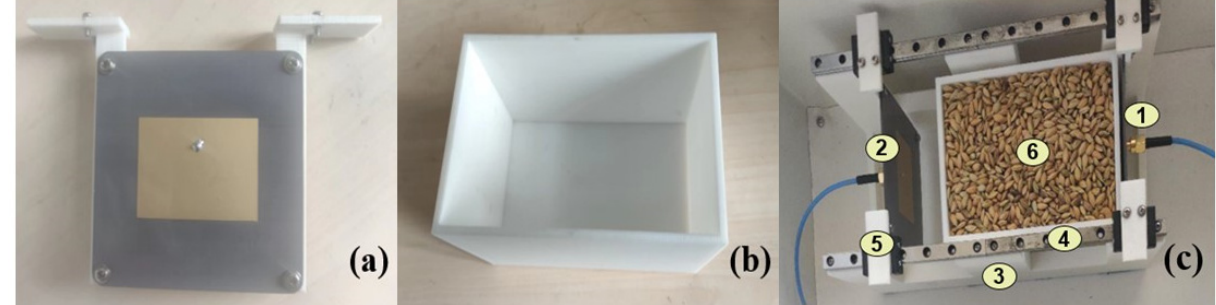
Figure 4. Real-time measurement module: ( a ) microstrip antenna; ( b ) sample cell; ( c ) real-time meas- urement module; ① , transmitting antenna; ② , receiving antenna; ③ , fixed base; ④ , guide rail; ⑤ , antenna fixing frame; ⑥ , measuring sample.